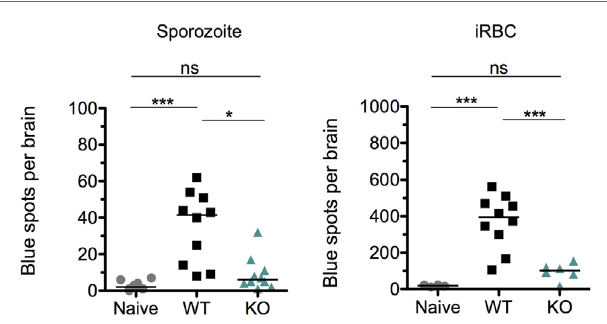
FigUre 8 | The cross-presentation of Pb1 by brain endothelial cells is reduced in KO-infected mice more after infected red blood cell (iRBC) than after sporozoite infection. Groups of 5 C57BL/6J mice were infected with 10 4 sporozoites or 10 6 iRBC of WT or KO and harvested when WT-infected mice exhibited neurological signs, i.e., on day 8 post-sporozoite injection and day 6 post-iRBC injection. An additional group of naïve mice were harvested for the assay. Brain microvessel fragments were isolated and co-incubated with reporter cells that express lacZ upon detection of a parasite-derived peptide-MHC complex ( Pb GAP50; SQLLNAKYL). Blue spots representing activated reporter cells were quantified following X-gal staining. The data shown are pooled values from two independent experiments with each point representing individual mice. The bars represent medians. One-way ANOVA was used after sporozoite infection while Kruskal–Wallis was used after iRBC infection to determine statistical significance; *** p < 0.0001, ** p < 0.001, and * p <